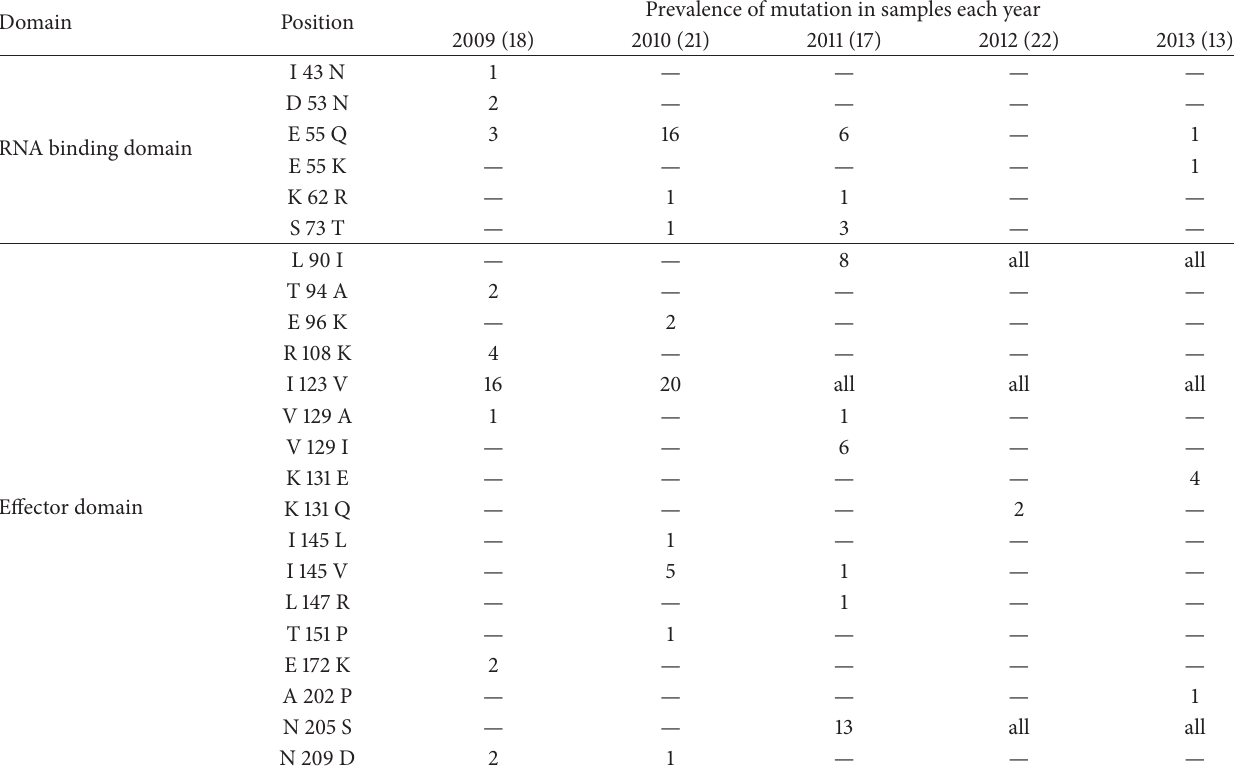
Table 2: Year-wise samples showing amino acid changes in different domains of NS1